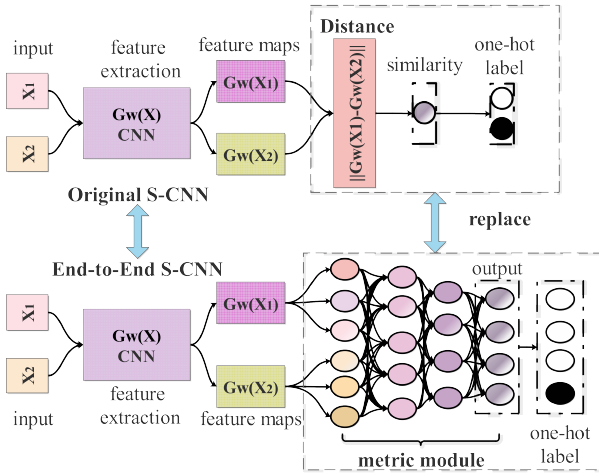
Figure 1. Architectures of SCNN and ES-CNN. Here the original SCNN is a binary classifier, which can learn the similarity of the input sample-pair. To deal directly with multi-classification, the ES-CNN applies a fully connected network to replace the metric function (distance) of SCNN.